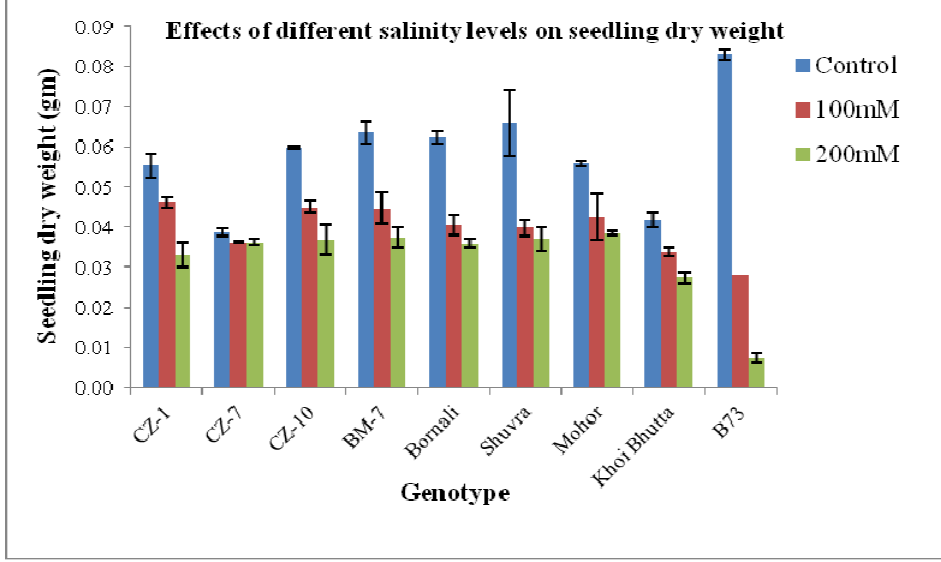
Fig. 5. Effects of different salinity levels on seedling dry weight.